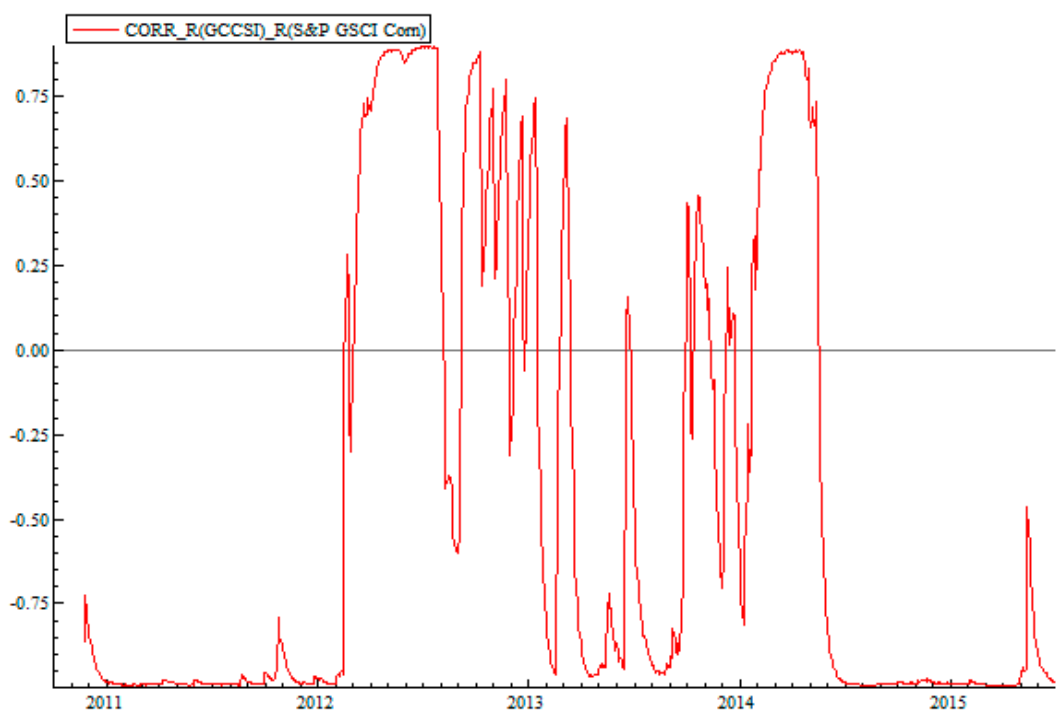
Figure 5. The evolution of the DCC behavior for panel b from 2010 to 2015.